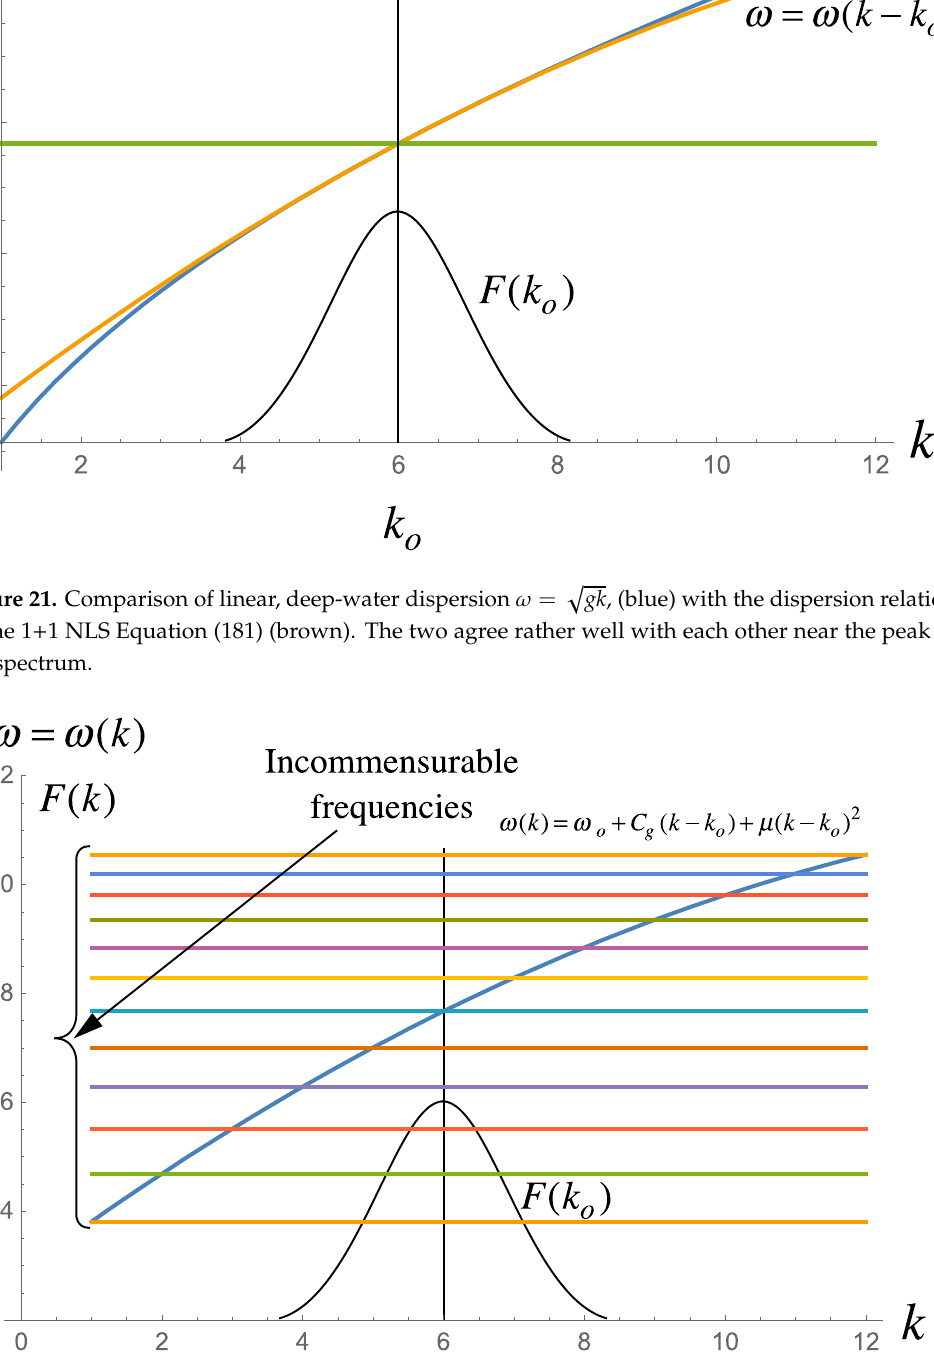
Figure 22. Incommensurable frequencies as a function of wavenumber for the 1+1 NLS equation (185).